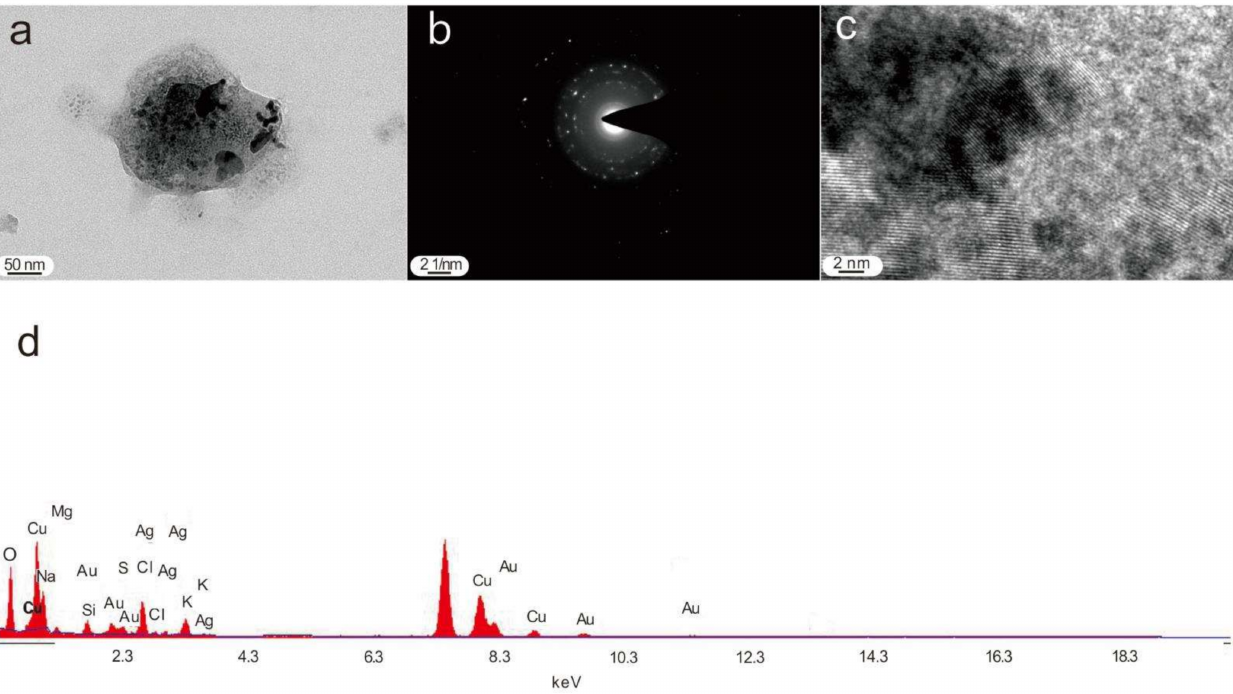
Figure 7. TEM photomicrographs of Au-bearng in the soil. ( a ) TEM image, SAED pattern ( b ), HRTEM image ( c ) and energy spectrum ( d